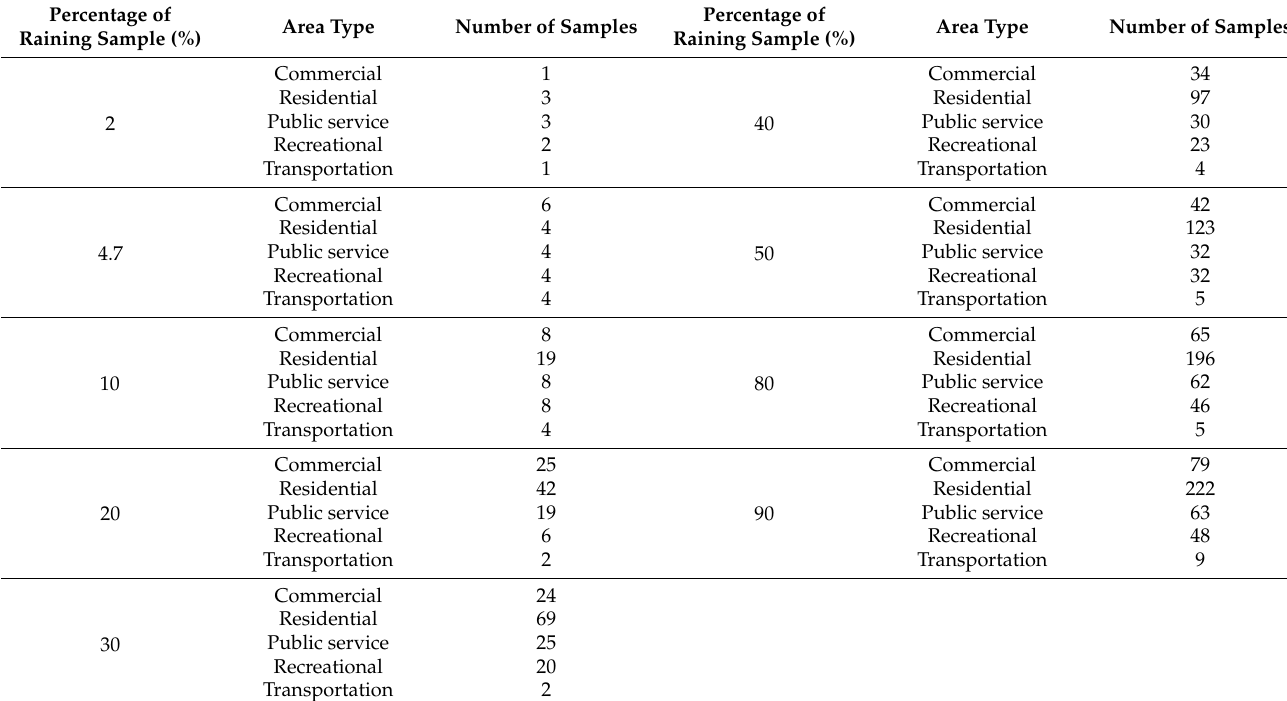
Table A2. Statistics of the training sets used for model comparison